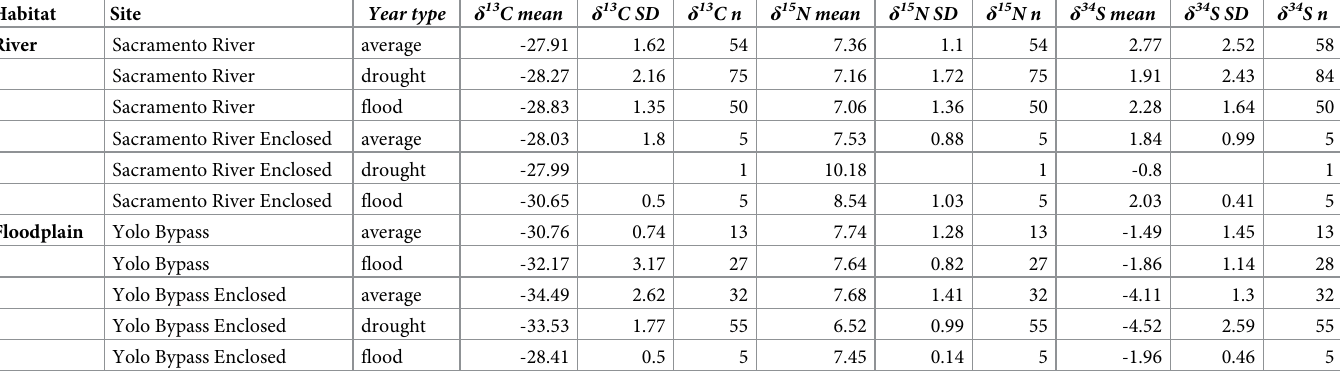
Table 2. Fish stomach content stable isotope data ( δ 13 C, δ 15 N, δ 34 S) for different hydrologic conditions from river and floodplain habitats. Enclosed sites include fish that were reared on the experimental fields or in cages. Habitat